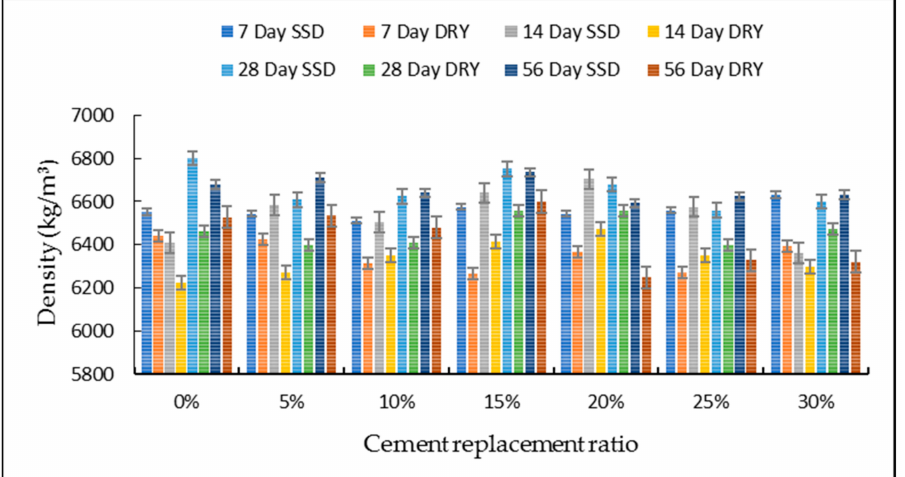
Figure 11. Density in SSD and dry